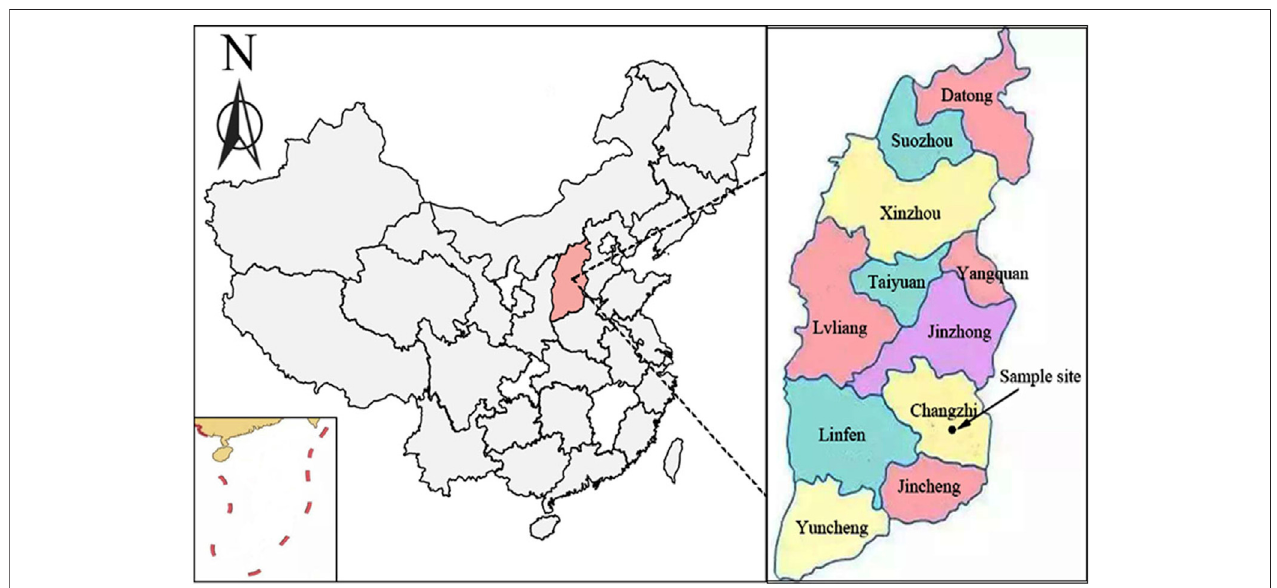
FIGURE 8 | Location of the Xiadian coal mine.